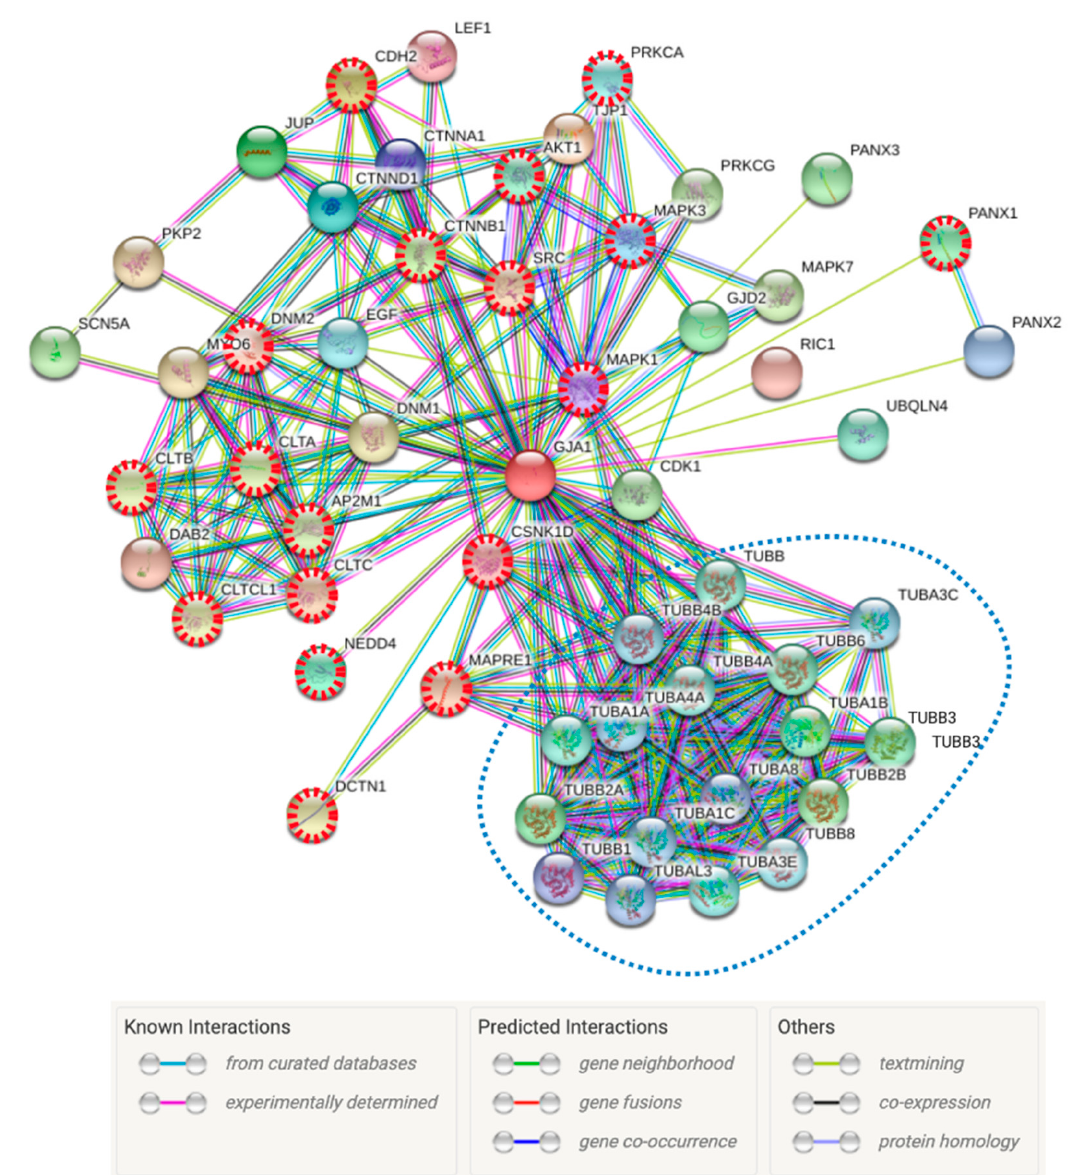
Figure 4. The Cx43 (GJA1) interactome is enriched with proteins associated with the IS. STRING analysis of the most prevalent Cx43 (GJA1) interacting proteins. Nodes with red non-continuous red lines are proteins with published evidence that strongly associate them with the IS (18 proteins). Included in the non-continuous blue line circle are highlighted the cluster containing 17 tubulins. The network was retrieved and constructed using the STRING database version 11.0, using a stringent confidence score prediction setting (>0.8), resulting in 54 interactions. Full names, score prediction and details of the top 25- interactions are shown in Table 1.